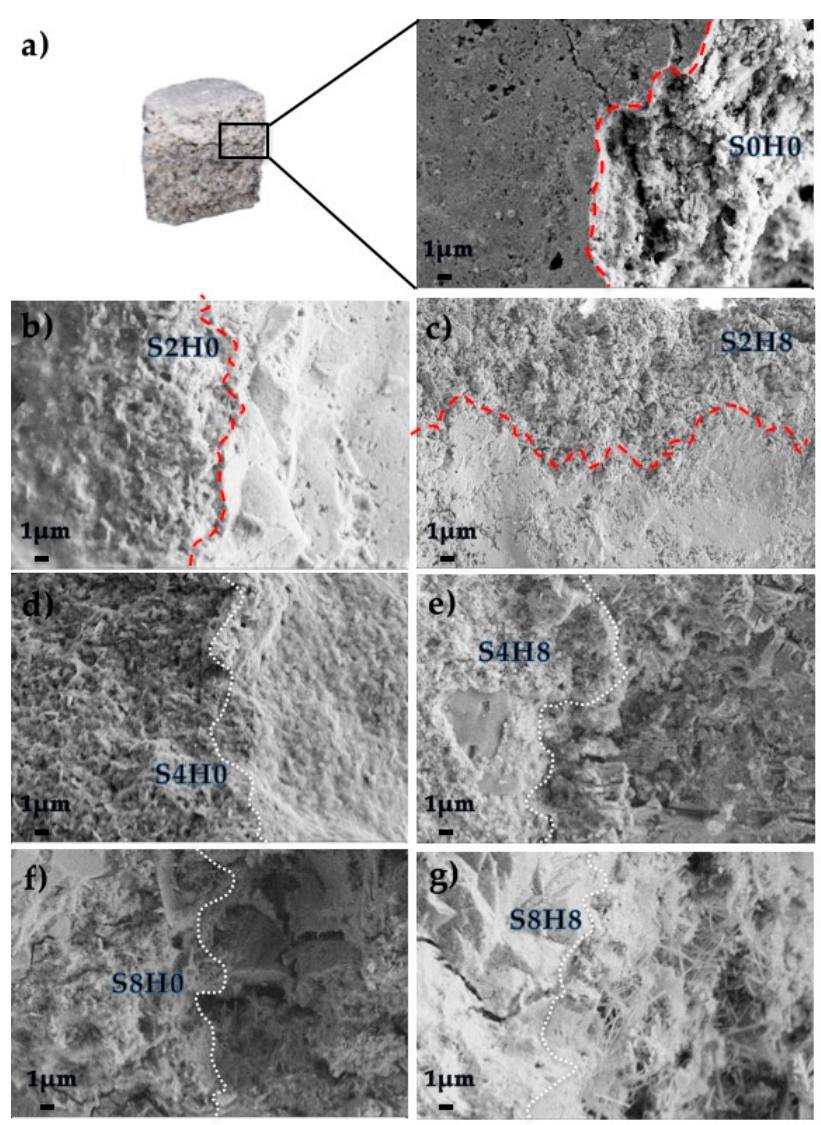
Figure 5. SEM images of top coating/bottom matrix interphases: ( a ) sketch of the interphase and morphology of the ITZ bottom matrix/S0H0 coating; ( b ) ITZ bottom matrix/S2H0 coating; ( c ) ITZ bottom matrix/S2H8 coating; ( d ) ITZ bottom matrix/S4H0 coating; ( e ) ITZ bottom matrix/S4H8 coating; ( f ) ITZ bottom matrix/S8H0 coating; ( g ) ITZ bottom matrix/S8H8 coating.